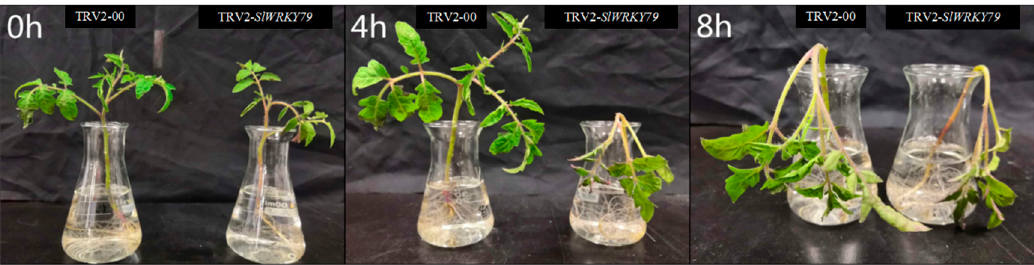
Figure 2. Phylogenetic tree of SlWRKY79, SlWRKY8, SlWRKY11, SlWRKY17, SlWRKY23,